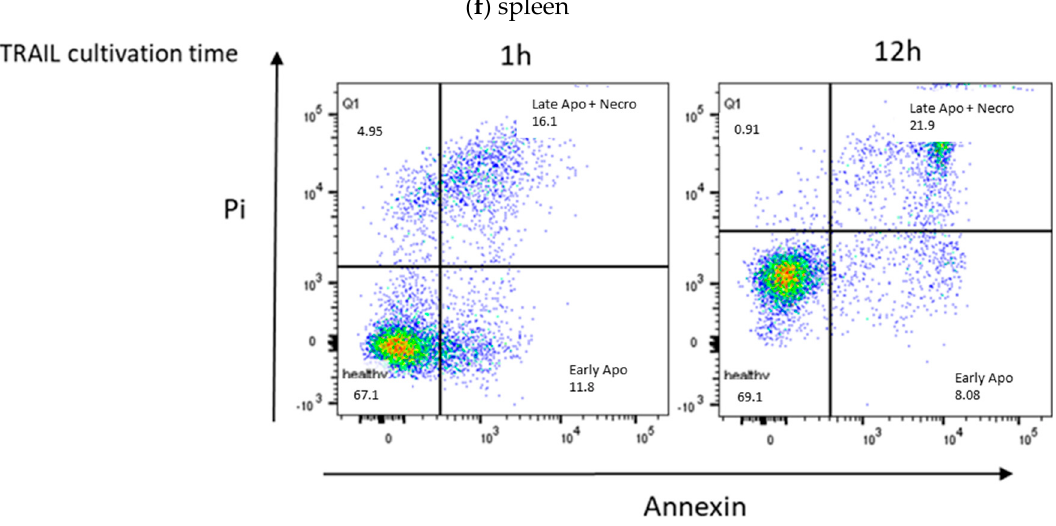
Figure 4. Impact of TRAIL stimulation on apoptosis in neutrophils derived from BM and spleen of septic WT mice. Neutrophils of septic WT mice 6 h after CASP induction ( n = 5) were cultured for 1 and 12 h with and without recombinant TRAIL in vitro. ( a ) Percentage of early apoptotic and ( b ) late apoptotic and necroptotic neutrophils of BM, ( d ) early apoptotic and ( e ) late apoptotic and necroptotic neutrophils of the spleen are shown ( n = 5 each). Representative FACS plots show staining of neutrophils derived from the bone marrow ( c ) and the spleen ( f ). Graphs show mean ± SEM (* p < 0.05).